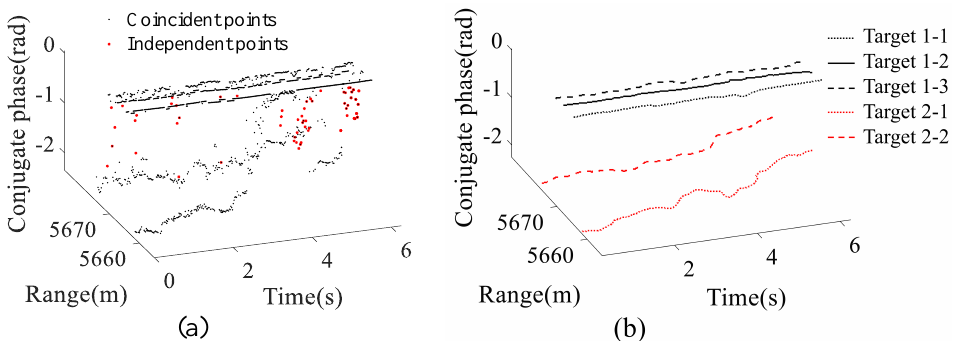
Figure 10. The experimental results of the proposed MDCM-LT algorithm. ( a ) The coincident points differentiated through the MDCM-based measurement partitioning method. ( b ) The tracking results derived through the LT